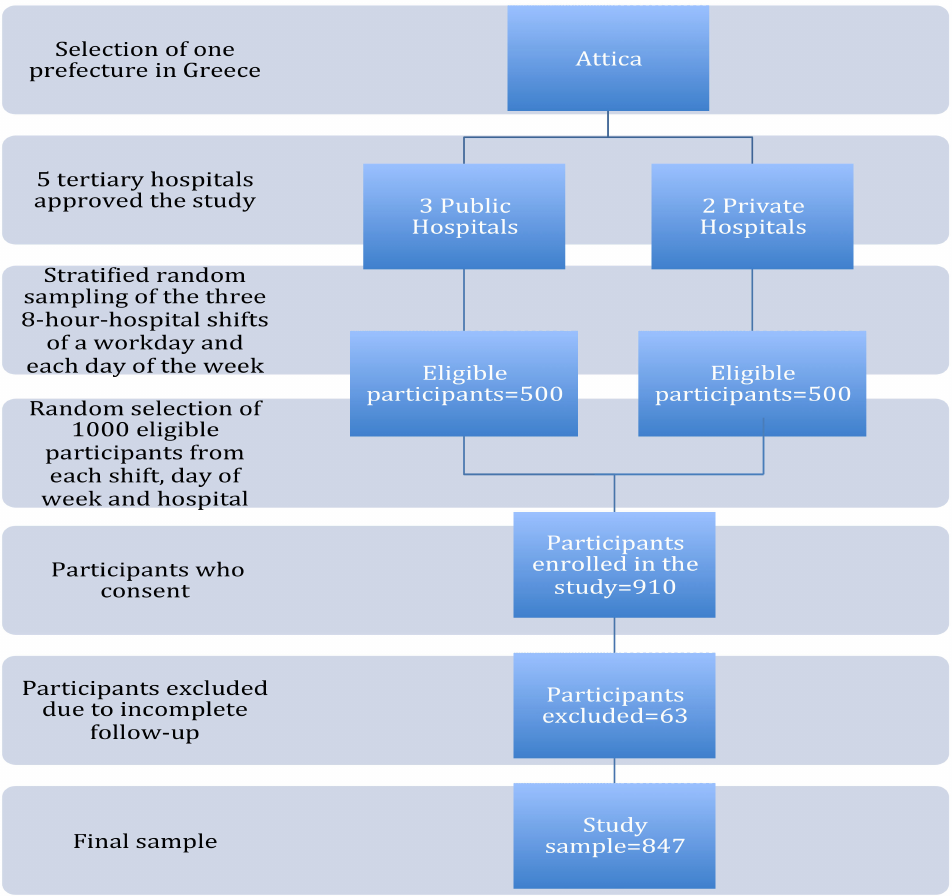
Figure 1. Flowchart of the process of the multistage stratified random sampling method used in the